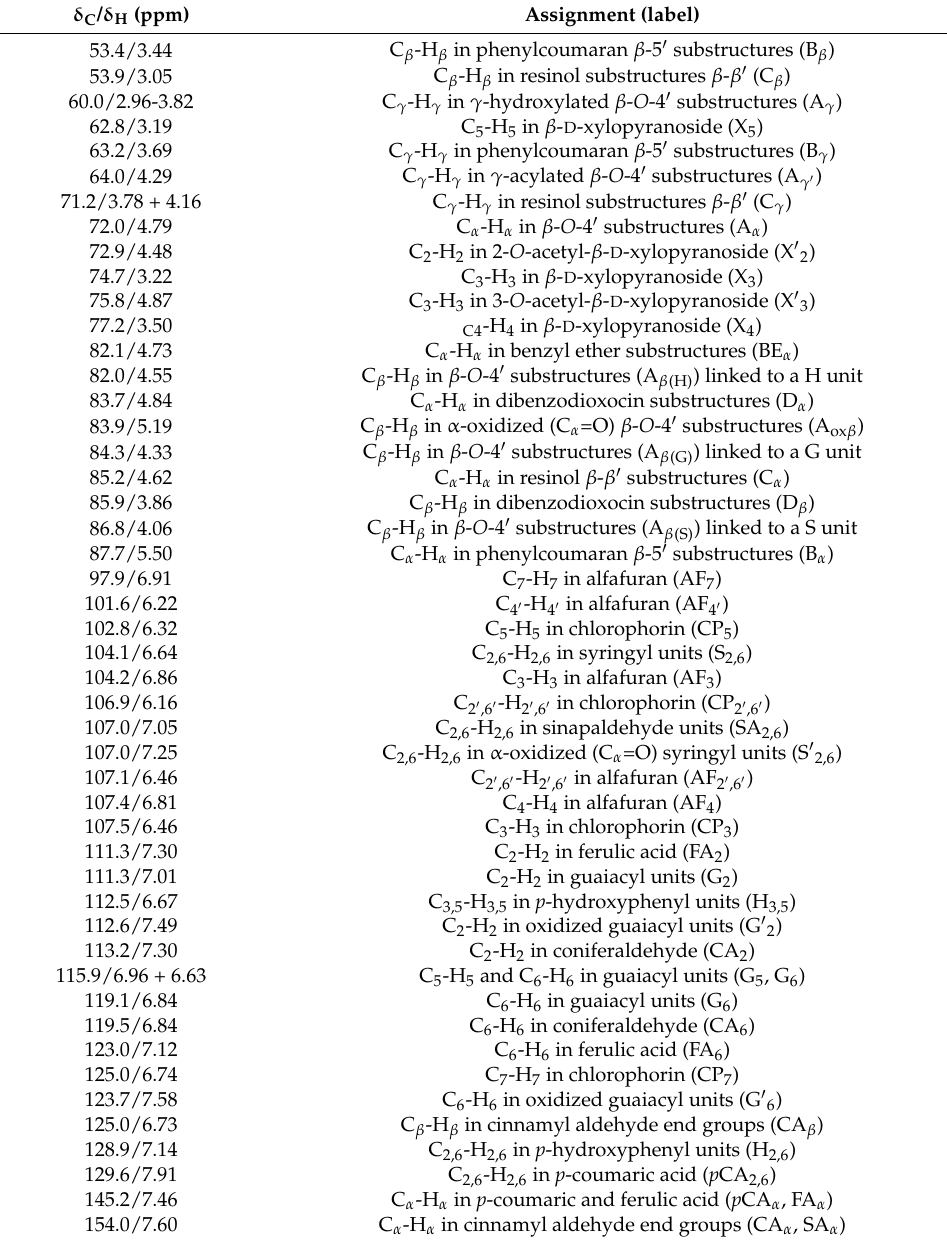
Table 3. Signal assignments of the 13 C − 1 H correlation peaks in the 2D HSQC NMR spectra of the isolated lignin fractions, according to Christensen [17], del Rio et al. [33], Kim and Ralph [34], Lourenço et al. [35], Noguchi et al. [36] and Ralph et al. [39]. The labels correspond to the respective lignin substructures shown in Figure